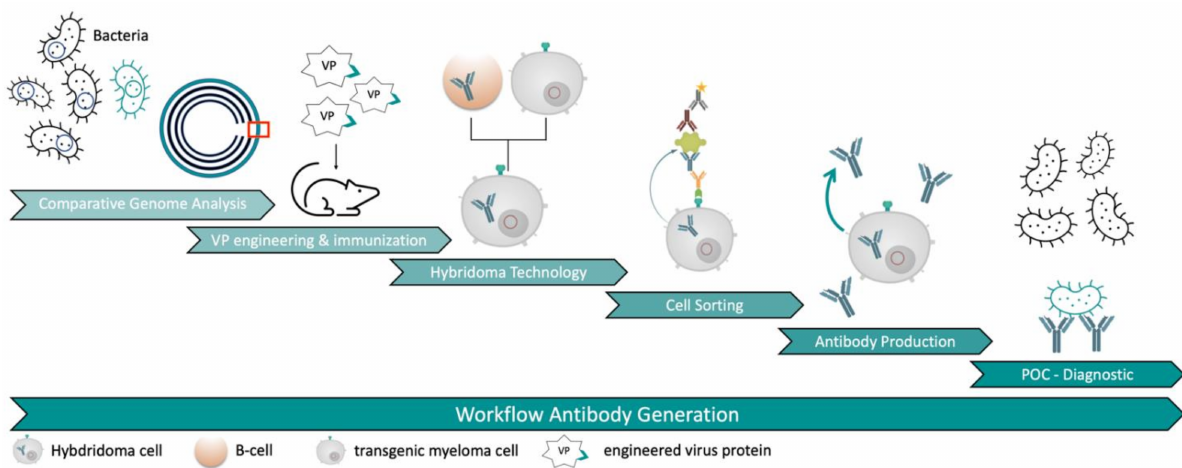
Figure 1. Schematic representation of the workflow for generating specific antibodies targeting a particular bacteria strain of